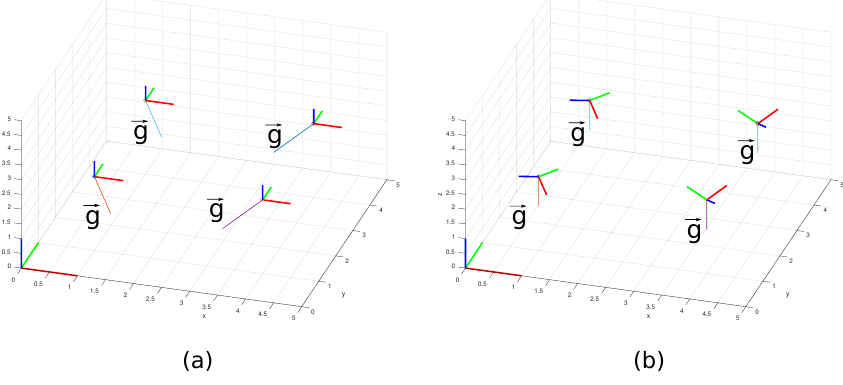
Figure 15. Axes references for ( a ) local and ( b ) global. The most important information from the accelerometer is to obtain the angle between the y -axis and the g . Furthermore, the most critical requirement is to ensure that at least one axis is parallel to the cable. Since, in this case, the y-axis is parallel, then the x - and z -axes relative to the global reference are irrelevant. The angle θ between the y -axis and the g is given as